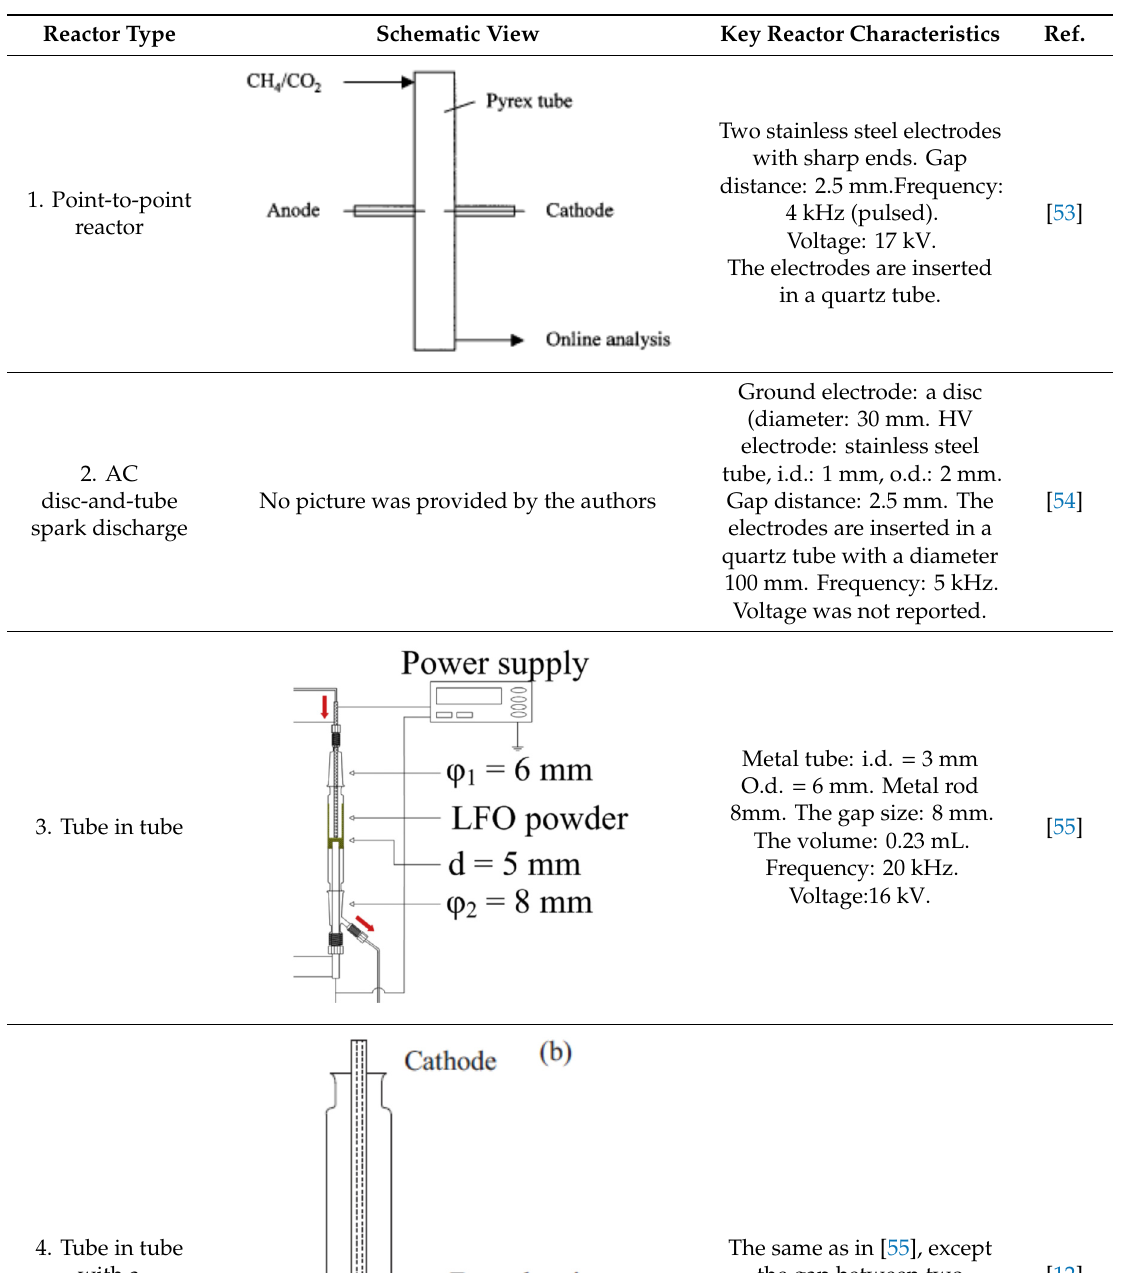
Table 2. Examples of plasma reactors applied in the DRM reaction and related experimental conditions.